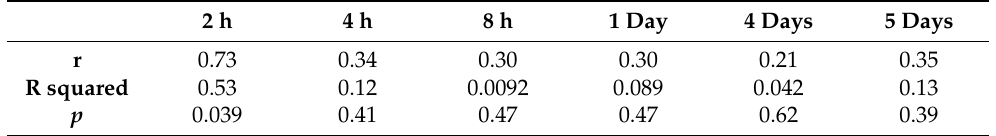
Table 2. Pearson correlation coefficie©(r), R squared and p for tracer accumulation versus NF- κ B p65 translocation at varying radial distances from the centre of the well after different durations of shear. 2